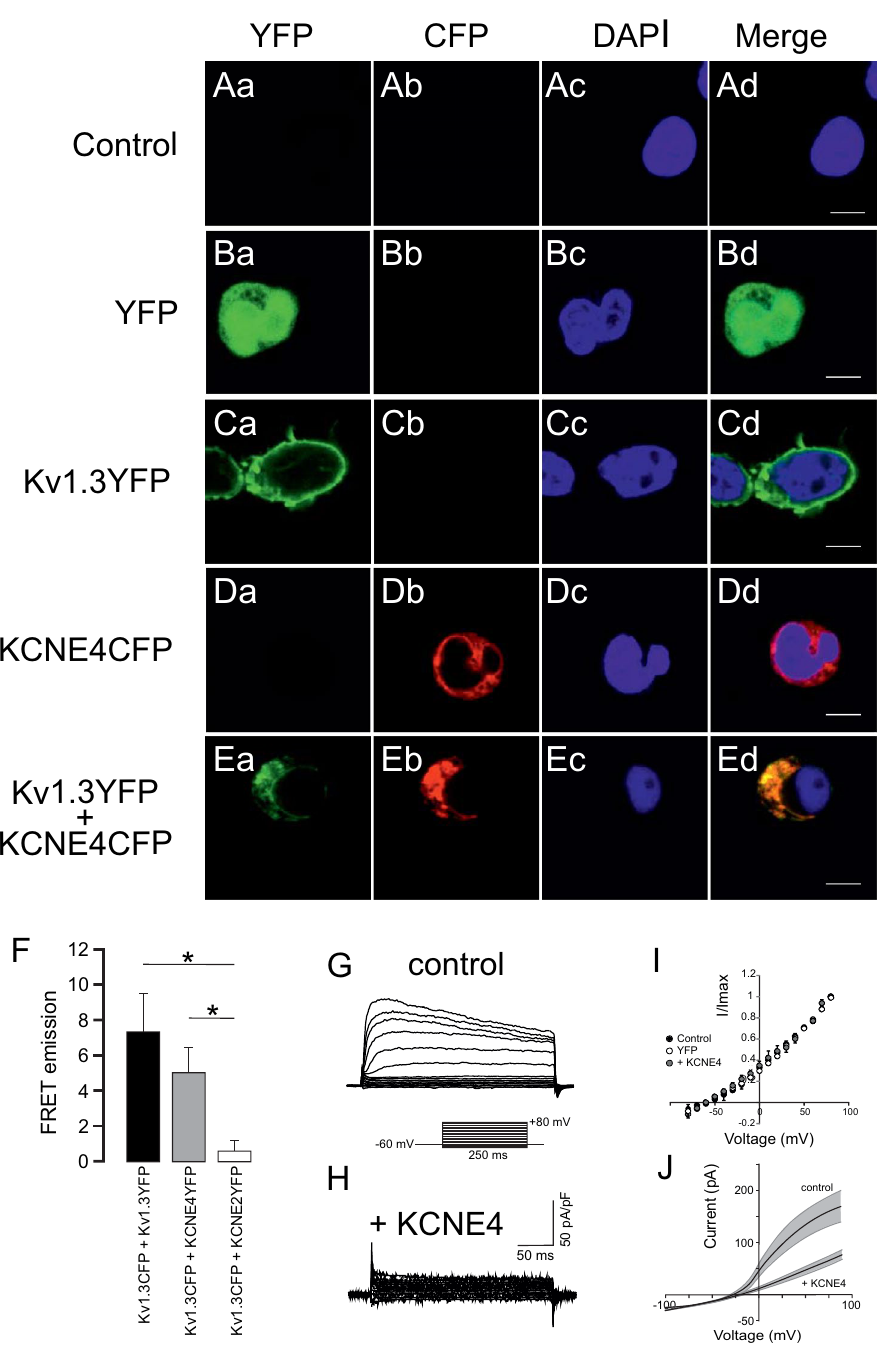
Figure 2. KCNE4 expression impairs Kv1.3 surface expression and inhibits Kv currents in Jurkat T cells. Confocal imaging of Jurkat T cells transfected with YFP, Kv1.3YFP, KCNE4CFP and KCNE4CFP with YFP-Kv1.3. Nuclei were stained with DAPI (blue). ( Aa – Ad ) Jurkat nontransfected cells (control). ( Ba – Bd ) YFP-transfected cells (YFP). ( Ca – Cd ) Kv1.3YFP transfected cells. ( Da – Dd ) KCNE4CFP transfected cells. ( Ea – Ed ) Kv1.3YFP and KCNE4CFP cotransfected cells. ( Aa , Ba , Ca , Da , Ea ) Kv1.3 in green. ( Ab , Bb , Cb , Db , Eb ) KCNE4 in red. ( Ac , Bc , Cc , Dc , Ec ) DAPI in blue. Merged yellow indicates colocalization between green and red ( Ad , Bd , Cd , Dd , Ed ). Scale bar: 5 µm. ( F ) FRET analysis of the Kv1.3-KCNE4 protein interaction by flow cytometry in Jurkat T lymphocytes. Values are mean ± SE, n = 5–7, *p < 0.05 (Student’s t -test). Kv1.3CFP-Kv1.3YFP was used as a positive control, whereas Kv1.3CFP-KCNE2YFP served as the negative control. ( G , H ) Representative current traces obtained from control Jurkat T cells ( G ) and cells positively transfected with KCNE4CFP ( H ). Cells were clamped at -60 mV, and K + currents elicited by 250 ms voltage steps from -80 mV to +80 mV in 10-mV increments. ( I ) I/Imax plotted against voltage (mV). Black circles, control cells (n = 21); white circles, YFP (n = 4); gray circles, + KCNE4CFP cells (n = 6). ( J ) Kv currents recorded in the whole-cell configuration by depolarizing ramps from -100 to +100 mV. Each black trace represents the average ± SE (shadowed in gray) of several ramps. Traces shown for control Jurkat T cells (n = 22) and + KCNE4CFP (n =